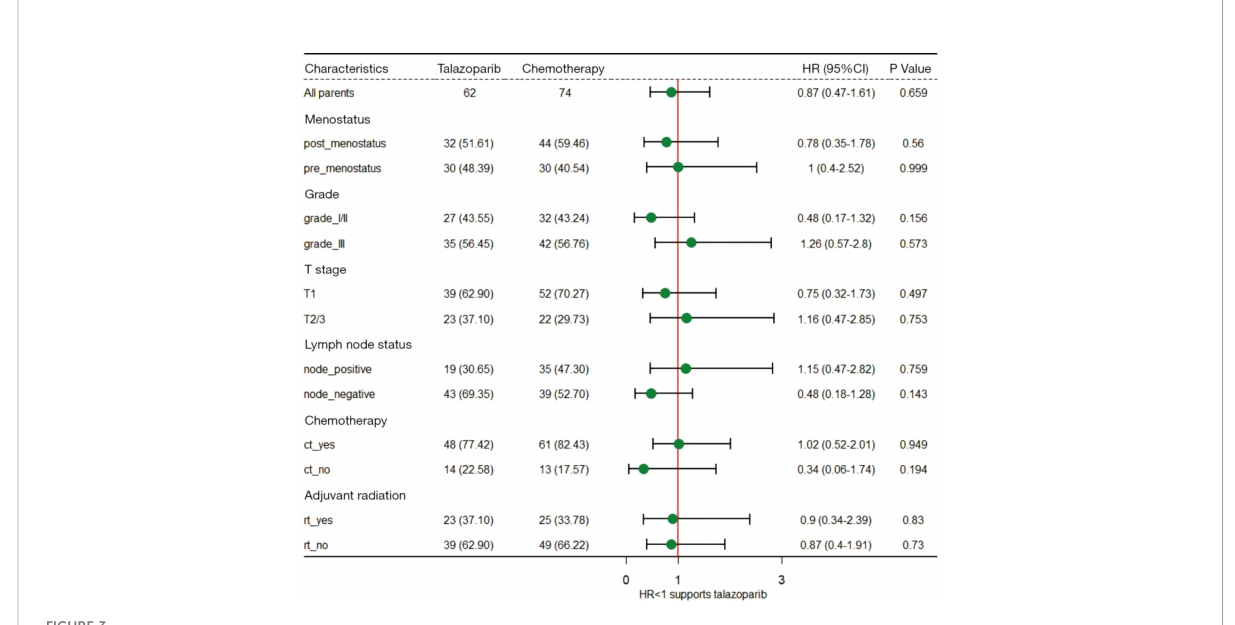
FIGURE 3 Exploratory subgroup analyses for disease-free survival.